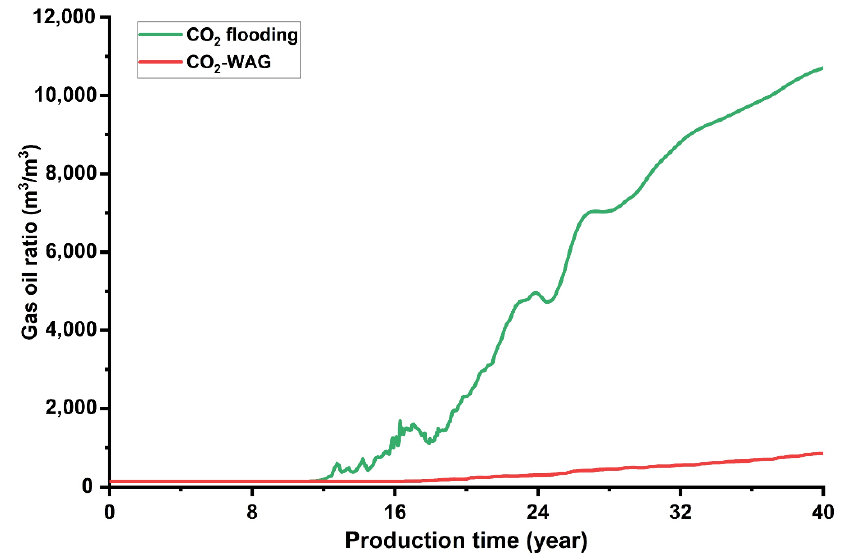
Figure 8. Gas oil ratio of the production in the WAG and CO 2 flooding.